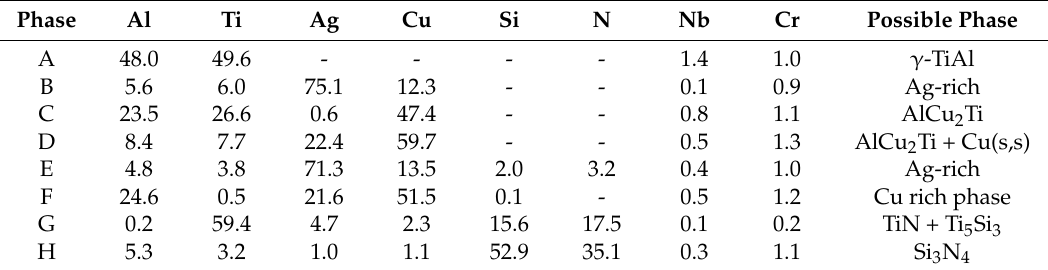
Figure 4. X-ray diffraction (XRD) results of the fracture surfaces brazed at 1173 K.